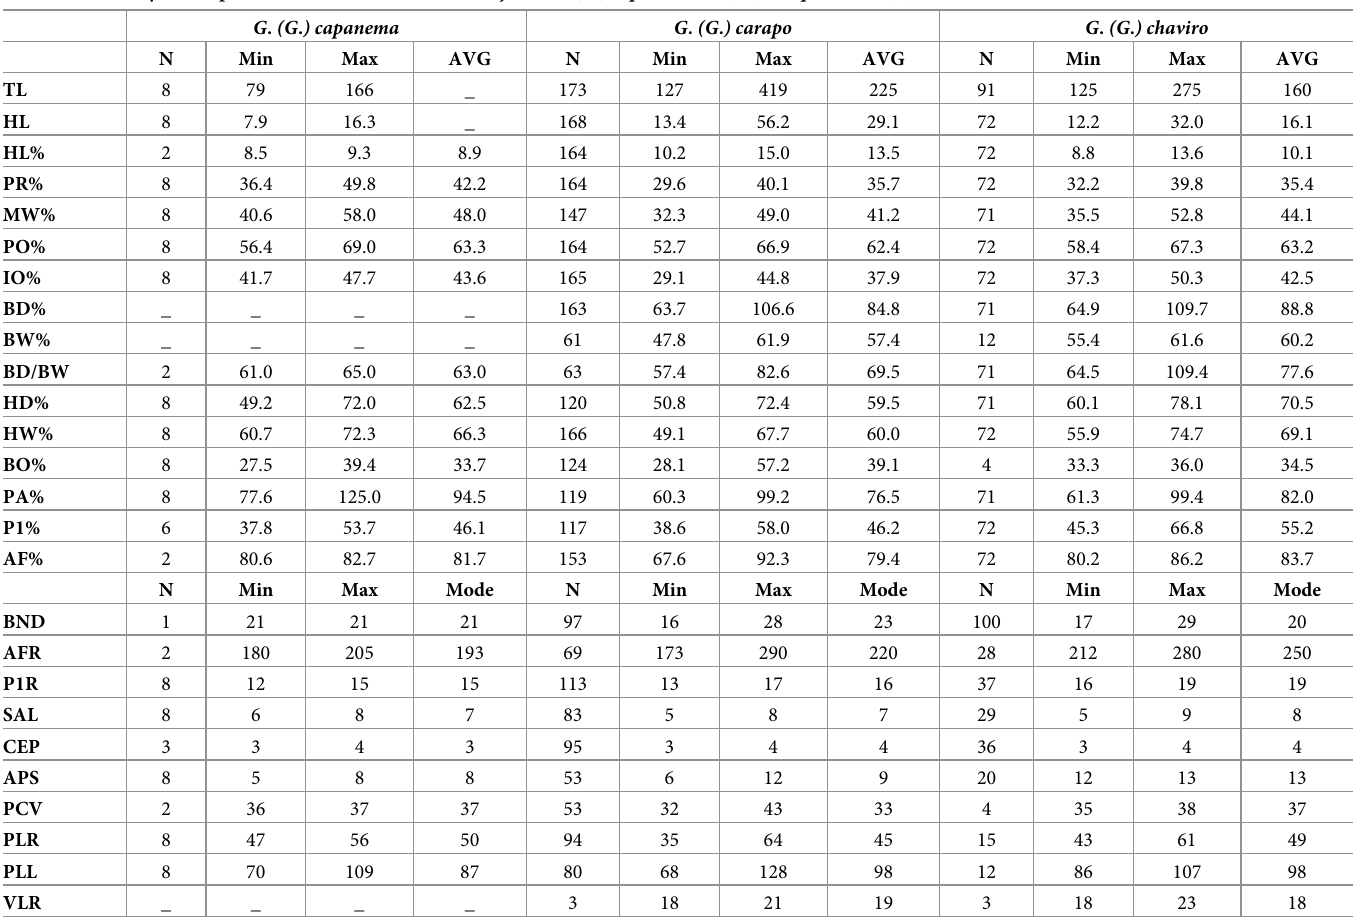
Table 7. Summary of morphometric and meristic data for Gymnotus (G . ) capanema , G . (G . ) carapo and G . (G . ) chaviro . G . (G . )